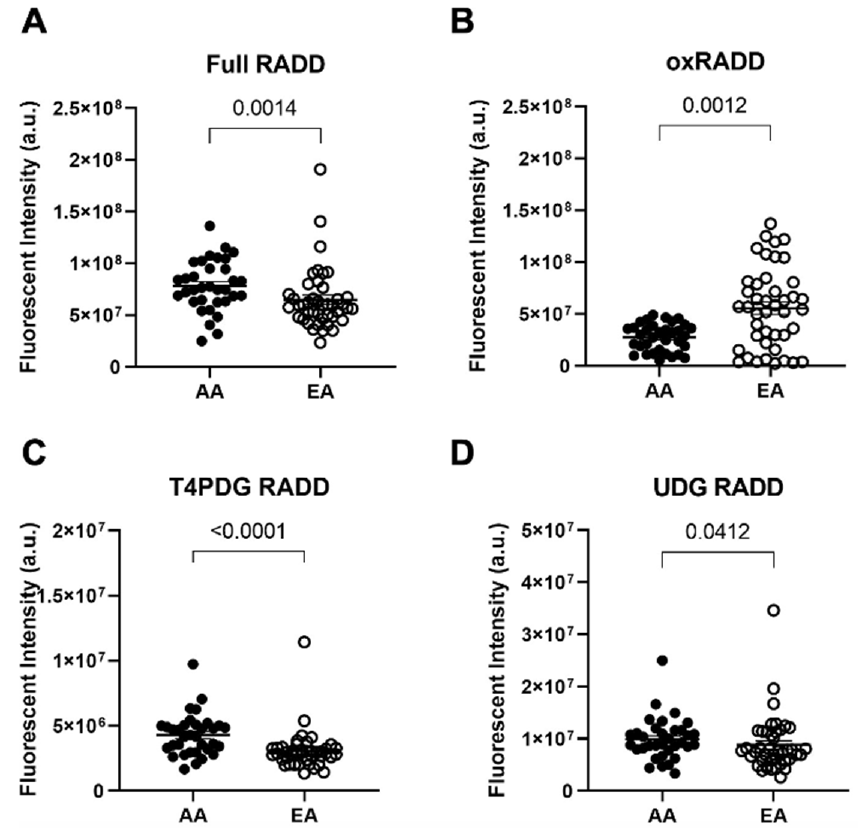
Figure 1. DNA damage detected by RADD demonstrates biological differences in DNA lesion types between African American and European American prostate cancer patients. Quantitative graphs measuring immunofluorescence for ( A ) Full RADD, ( B ) oxRADD, ( C ) T4PDG RADD, and ( D ) UDG RADD in AA and EA PCa patients ( n = 34 AA and 43 EA PCa patients). Data represented are the mean ± the standard error of the mean. The Mann–Whitney test was used to calculate statistical significance between groups. Images for each patient are provided in Supplemental Figure S2. The uracil lesion content within AA tumors is particularly interesting because the de novo pyrimidine biosynthesis pathway is a large source of uracil production. Genomic uracil content can result from an accumulation of dUMP that is not metabolized to de- oxythymidine monophosphate (dTMP), known as thymidylate stress (Figure 2A) [22,23]. Thymidylate stress is caused by a defective folate cycle that cannot metabolize tetrahydrofo- late (THF) to 5 (cid:48) ,10 (cid:48) -methylene-tetrahydrofolate (MTHF). Metabolites from the homocysteine- methionine and betaine-dimethyl glycine pathways help convert 5 (cid:48) -methyl-THF to THF to ensure the progression of the folate cycle (Figure 2A). Dysregulation of homocysteine metabolism, as well as de novo pyrimidine biosynthesis, can lead to uracil accumulation in DNA, resulting in DNA aberrations and defects in repair